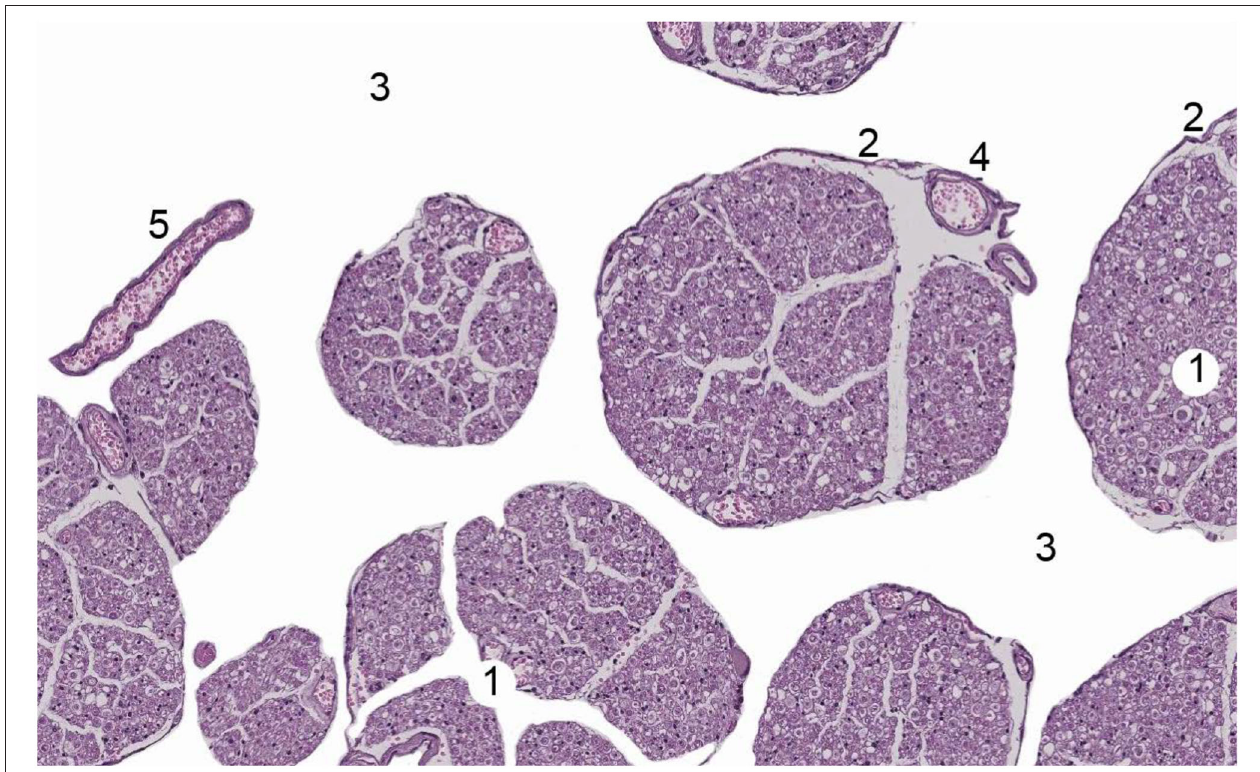
FIGURE 5 | Human nerve root of Cauda Equina. 1 = nerve root, 2 = Pia mater, 3 = cerebrospinal fluid, 4 = vessel within nerve root, 5 = a free vessel within cerebrospinal fluid. With permission of Dr. Miguel A.